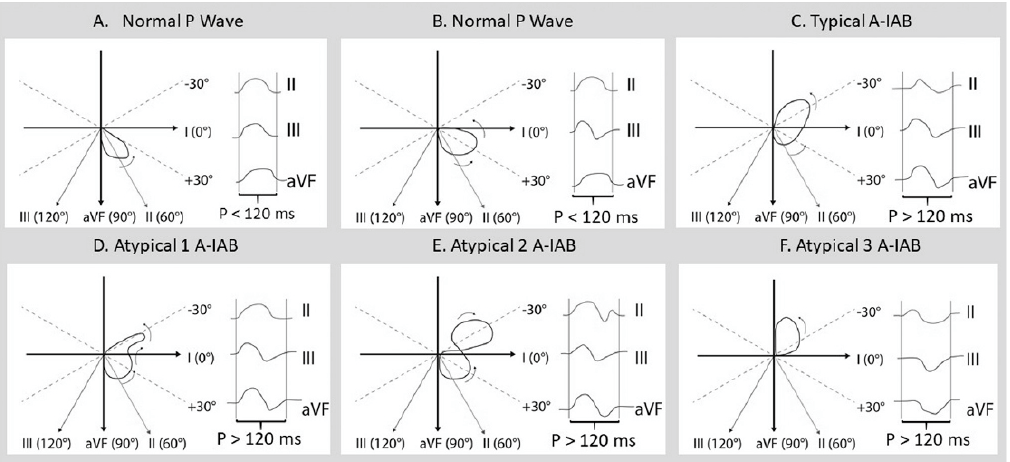
Figure 9. ( A , B ): Normal P-waves. In panel B, there is a biphasic ( ± ) pattern in lead III. This is considered normal because the last part of the P loop falls in the negative hemifield of lead III, that start at +30 ◦ but it is positive in leads II and aVF, because the P loop falls in positive hemifield of these leads that starts − 30 ◦ and 0 ◦ ( C ) typical A-IAB. The second part of the P loop falls in the negative hemifield of leads II, III and aVF. ( D – F ): the 3 atypical A-IAB patterns by morphology. (Taken from reference